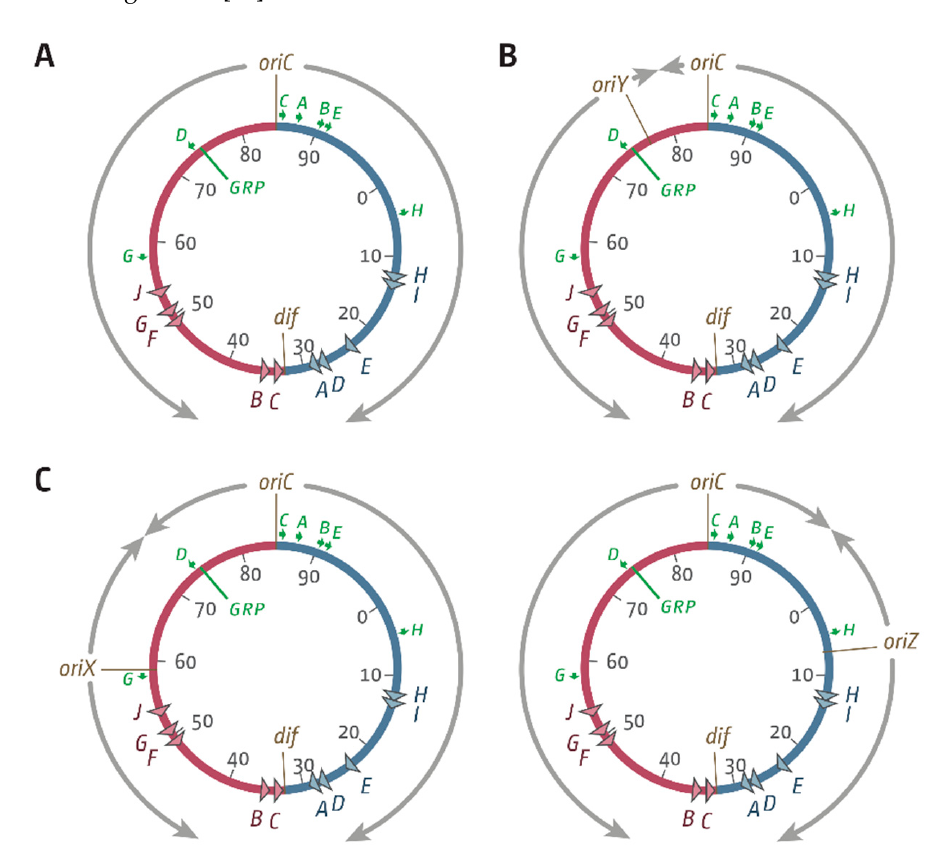
Figure 1. Schematic representation of the replichore arrangement of Escherichia coli chromosomes with ectopic replication origins in different locations. ( A ) Normal replichore arrangement in E. coli . The origin, oriC , and the dif chromosome dimer resolution site are indicated. ter sites are shown by triangles and are identified by their corresponding letter (“A” indicates the terA site). The numbers represent the minutes of the standard genetic map (0–100 min). Green arrows represent location and direction of transcription of the seven rrn operons: A–E, G, and H. The location marked “GRP” indicates a tight cluster of genes coding for ribosomal proteins, all of which are transcribed co-directionally with replication coming from oriC . ( B ) Integration site of a 5 kb oriC fragment termed oriY into malT upstream of the rrnD operon. ( C ) Integration sites of 5 kb oriC fragments into pheA upstream of the rrnG operon, termed oriX (this study), and near the lacZYA operon, termed oriZ [18,19]. In a recent study, Wang and colleagues reported the integration of a 5 kb oriC fragment called oriZ near the lac operon at 7.4 min into the E. coli chromosome, halfway into the right-hand replichore (Figure 1C) [19]. oriC + oriZ + cells grew with doubling times similar to wild-type cells, and